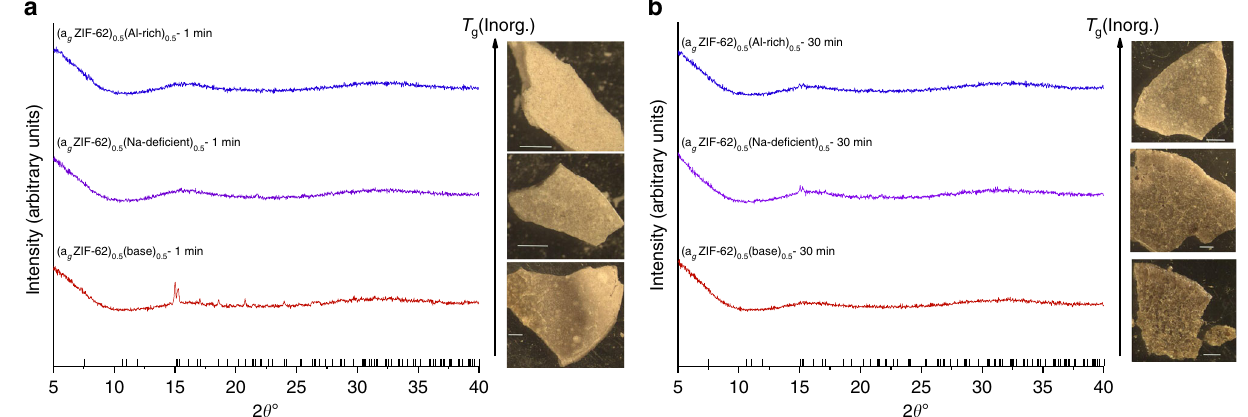
Fig. 7 X-ray diffraction patterns and light microscopy. PXRD and light microscopy (inset). a (a g ZIF-62) 0.5 (Inorganic Glass) 0.5 – 1 min. b (a g ZIF- 62) 0.5 (Inorganic Glass) 0.5 − 30 min. Black check marks show positions of peaks in ZIF-zni 34 . An offset has been added to improve readability. The white bar in each image is 1